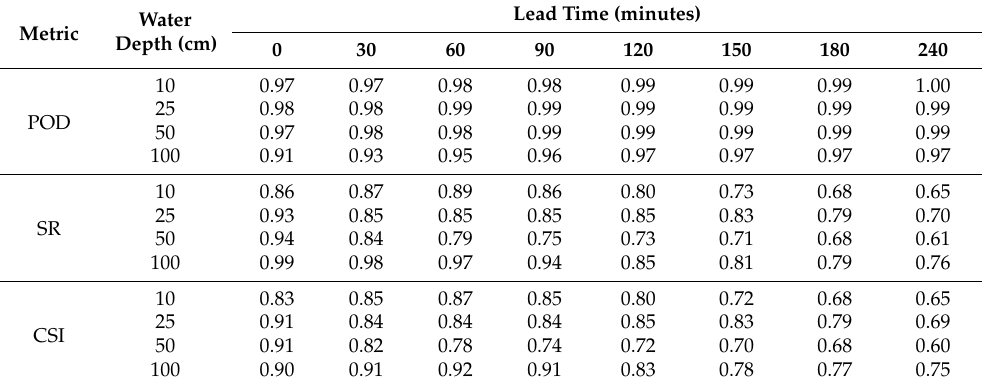
Table 3. Contingency metrics at different lead times for the POI 1.